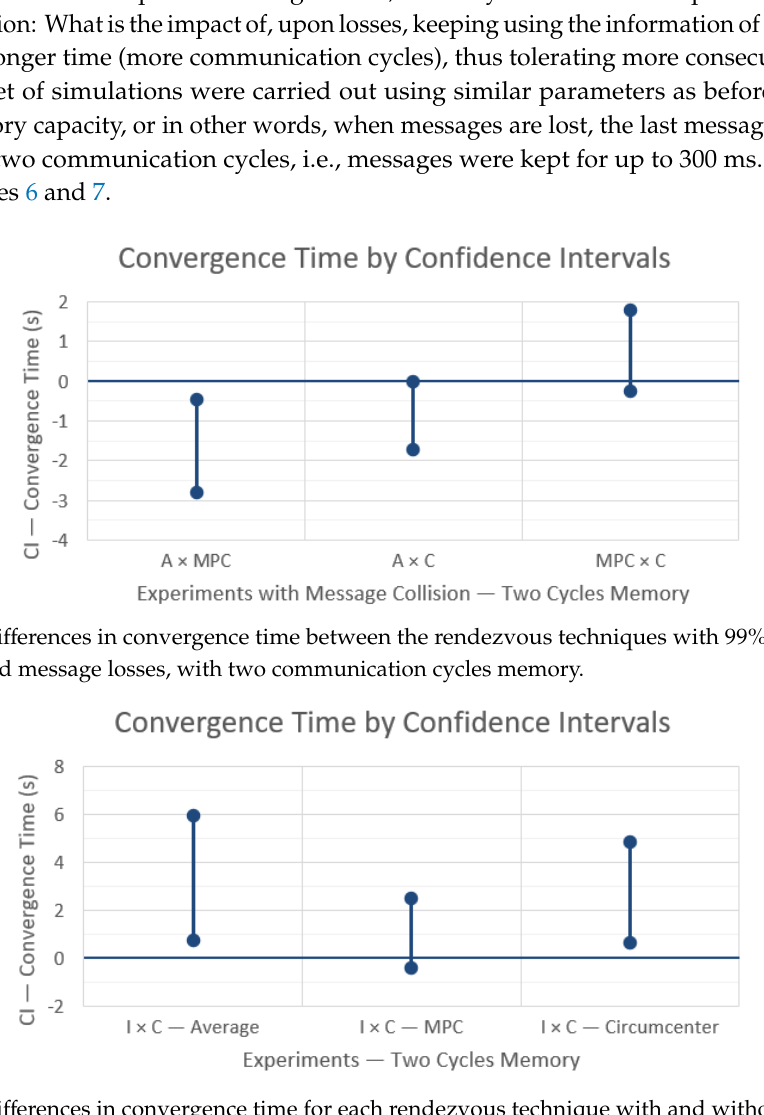
Figure 7. Differences in convergence time for each rendezvous technique with and without message losses, with two communication cycles memory, and with 99% confidence intervals.